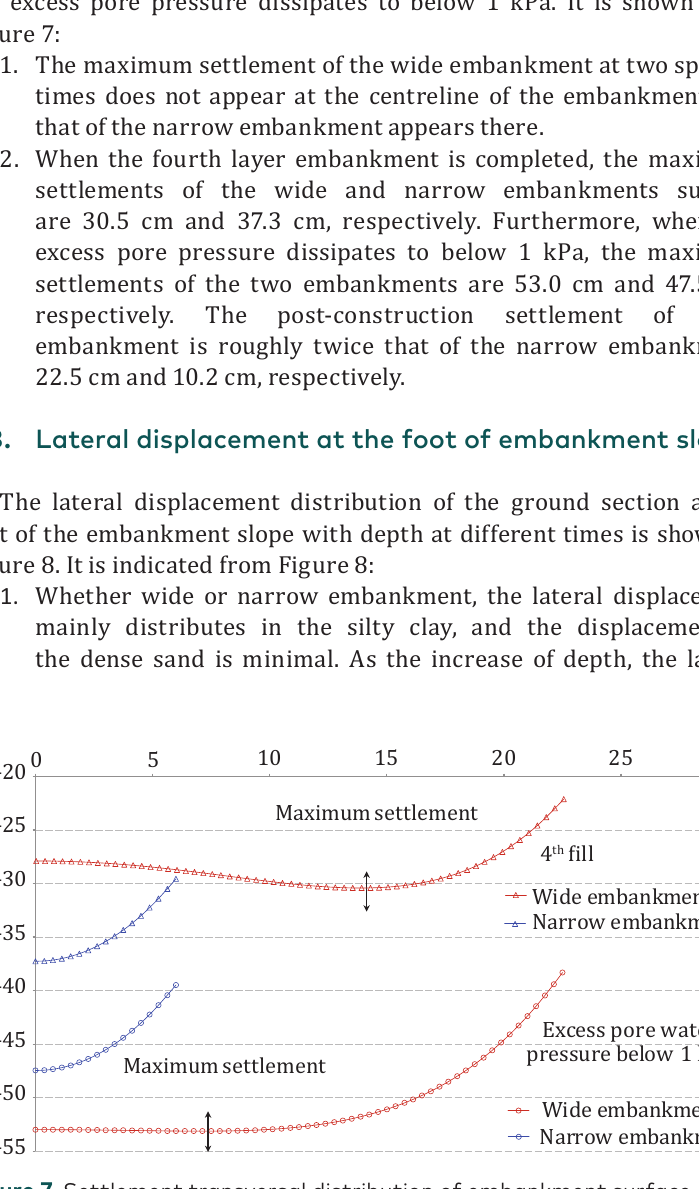
Figure 7. Settlement transversal distribution of embankment